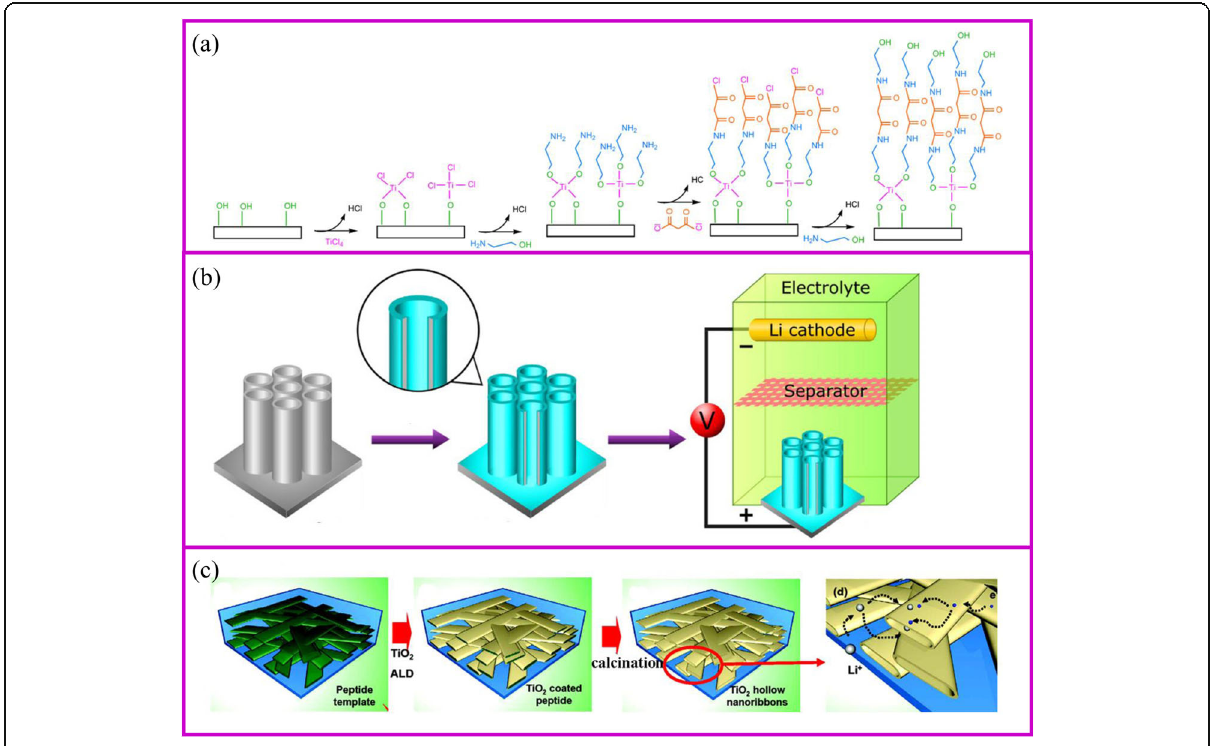
Fig. 5 a The ALD technique mechanism [81], and two examples for b surface coating [82] and c active materials fabrication